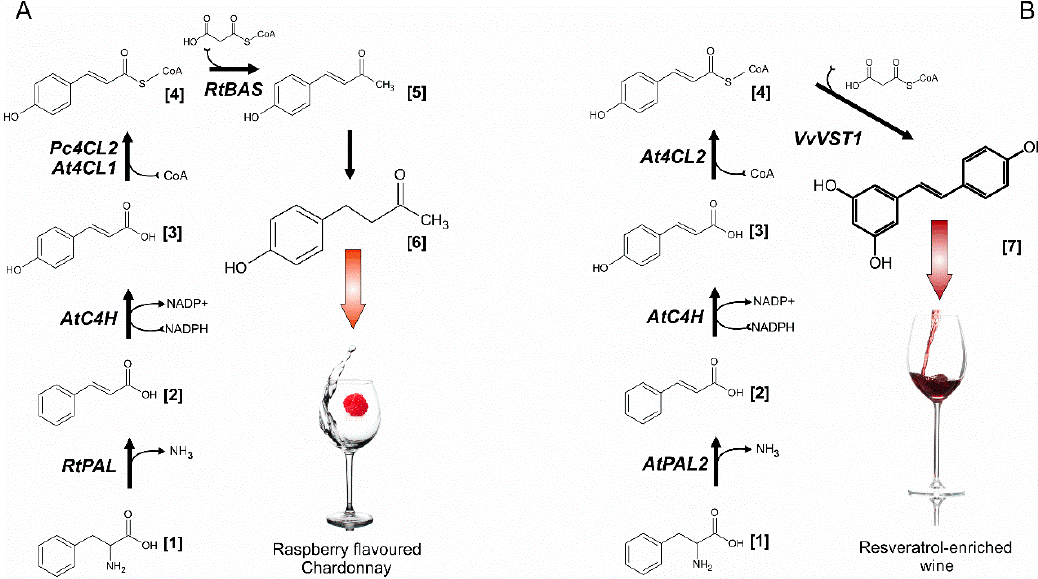
Figure 1 . Reconstruction of biosynthetic pathways for production of frambion ( A ) or resveratrol ( B ) Figure 1. Reconstruction of biosynthetic pathways for production of frambion ( A ) or